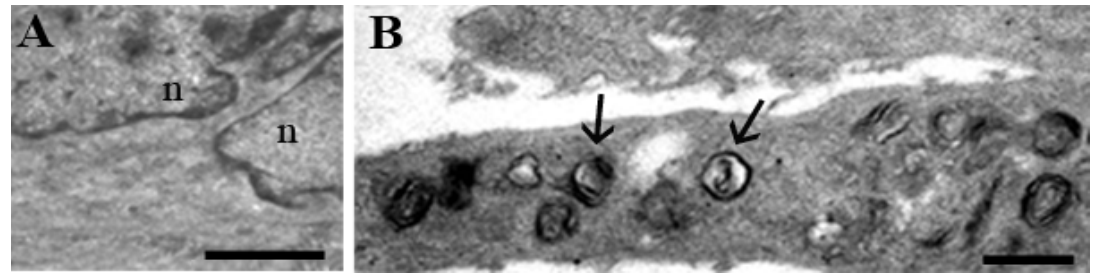
Figure 5. Autophagy occurs in UVB-radiation response of differentiated C2C12 cells. Autophagic vacuoles (arrows), absent in C2C12 control myotubes ( A ), appeared in UVB-treated myotubes ( B ). n: nuclei. Scale bars: ( A ) 2.5 µm; ( B ) 1 µm.